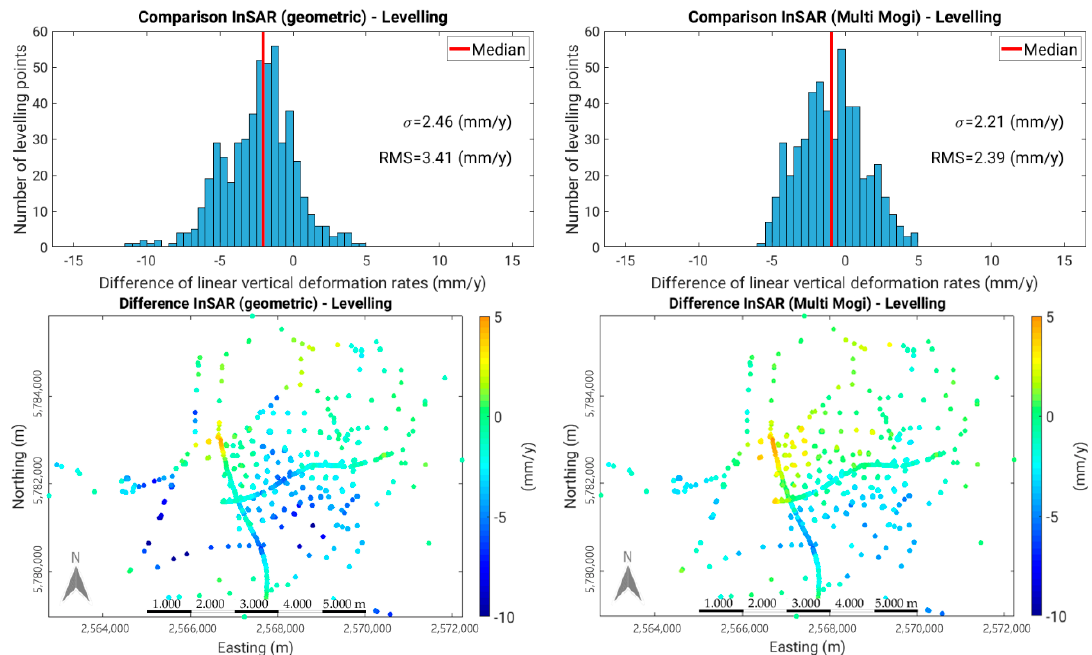
Figure 9. Histograms and scatter plots of differences between InSAR results and levelling. Left-hand side from geometric orbit combination, right-hand side Multi-Mogi approach.